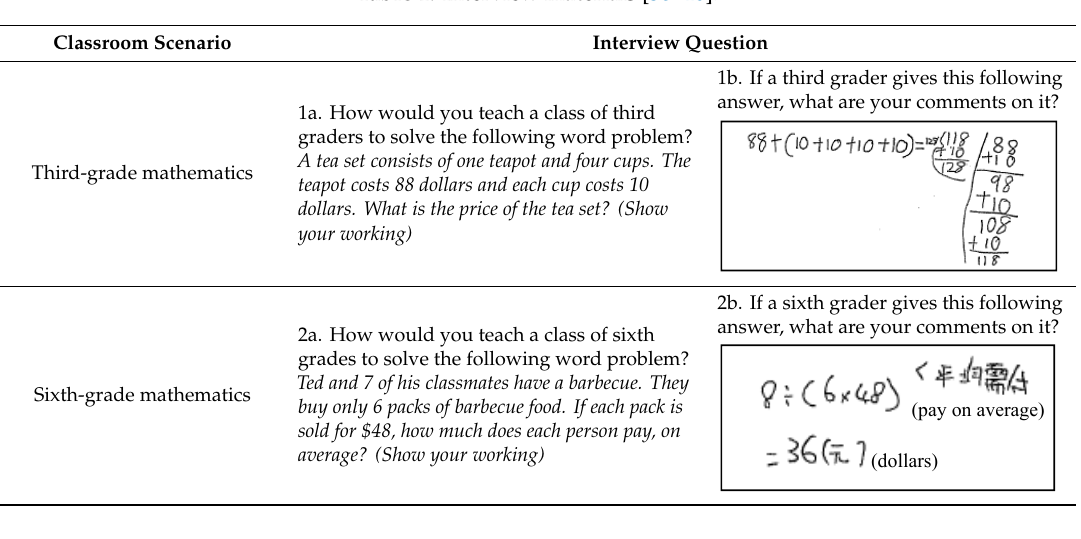
Table 1. Interview materials [38–40].